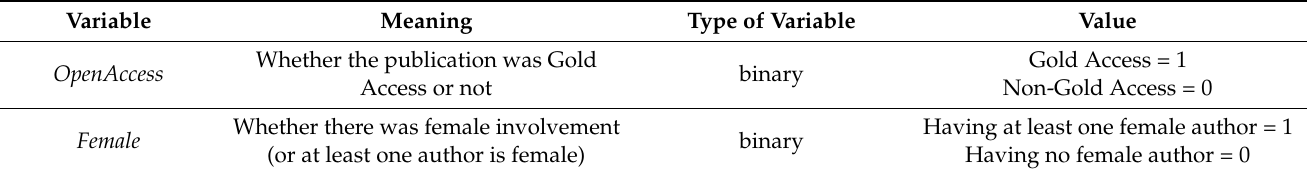
Table 1. Variable